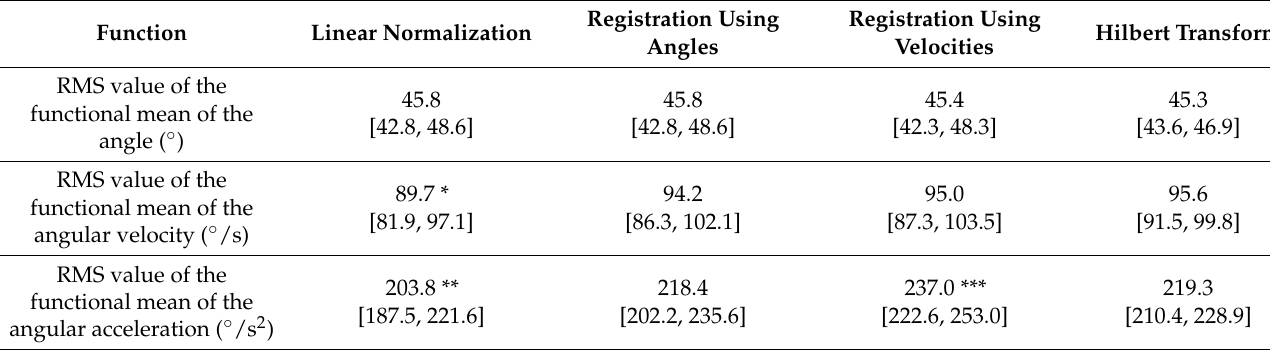
Table 1. Root Mean Square (RMS) values of the functional means of angles, angular velocities, and angular accelerations as a function of the time-scale normalization method. In parentheses, the 95% confidence interval.